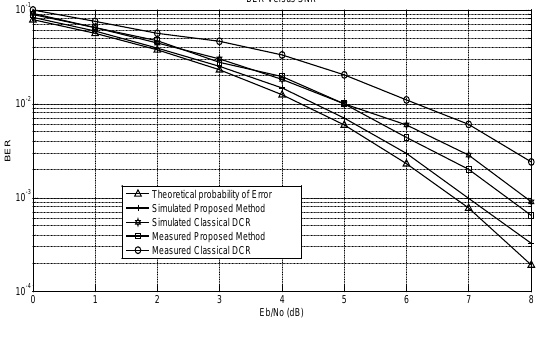
Figure 7: BER versus SNR